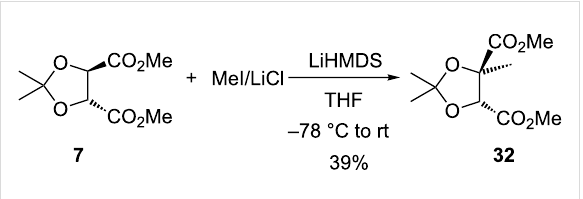
Scheme 8: Tartrate acetonide